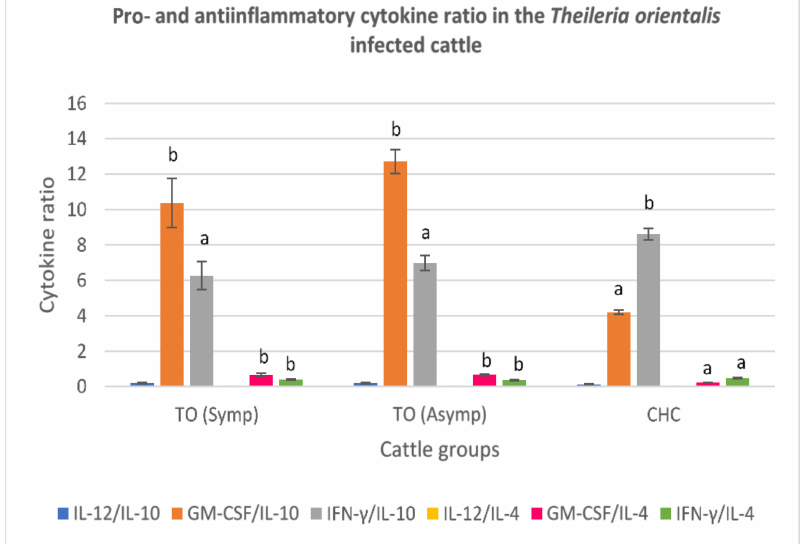
Figure 2. Pro- and anti-inflammatory cytokine ratio in symptomatic and asymptomatic cattle infected by Theileria orientlalis . Molecular detection and confirmation of T . orientalis was by PCR amplification of the MPSP gene. High serum GM-CSF:IL-10 and GM-CSF:IL-4, and low IL-12:IL-10 levels were observed in both symptomatic and asymptomatic cattle infected with Theileria orientalis. Also, low IL-12:IL-4 and IFN- γ :IL-10 levels were found in both symptomatic and asymptomatic T. orientalis infected cattle. TO (Symp): Symptomatic Theileria orientalis infected cattle. TO (Asymp): Asymp- tomatic Theileria orientalis infected cattle. CHC: Clinically healthy cattle (control). IL-12: Interleukin 12; IL-10: Interleukin 10; GM-CSF: Granulocyte Macrophage-colony stimulating factor; IFN- γ : Inter- feron gamma; IL-4: Interleukin 4. ( a , b ) Different superscripts refer to significant differences in the parameters between T. orientalis infected cattle and clinically healthy cattle ( p <